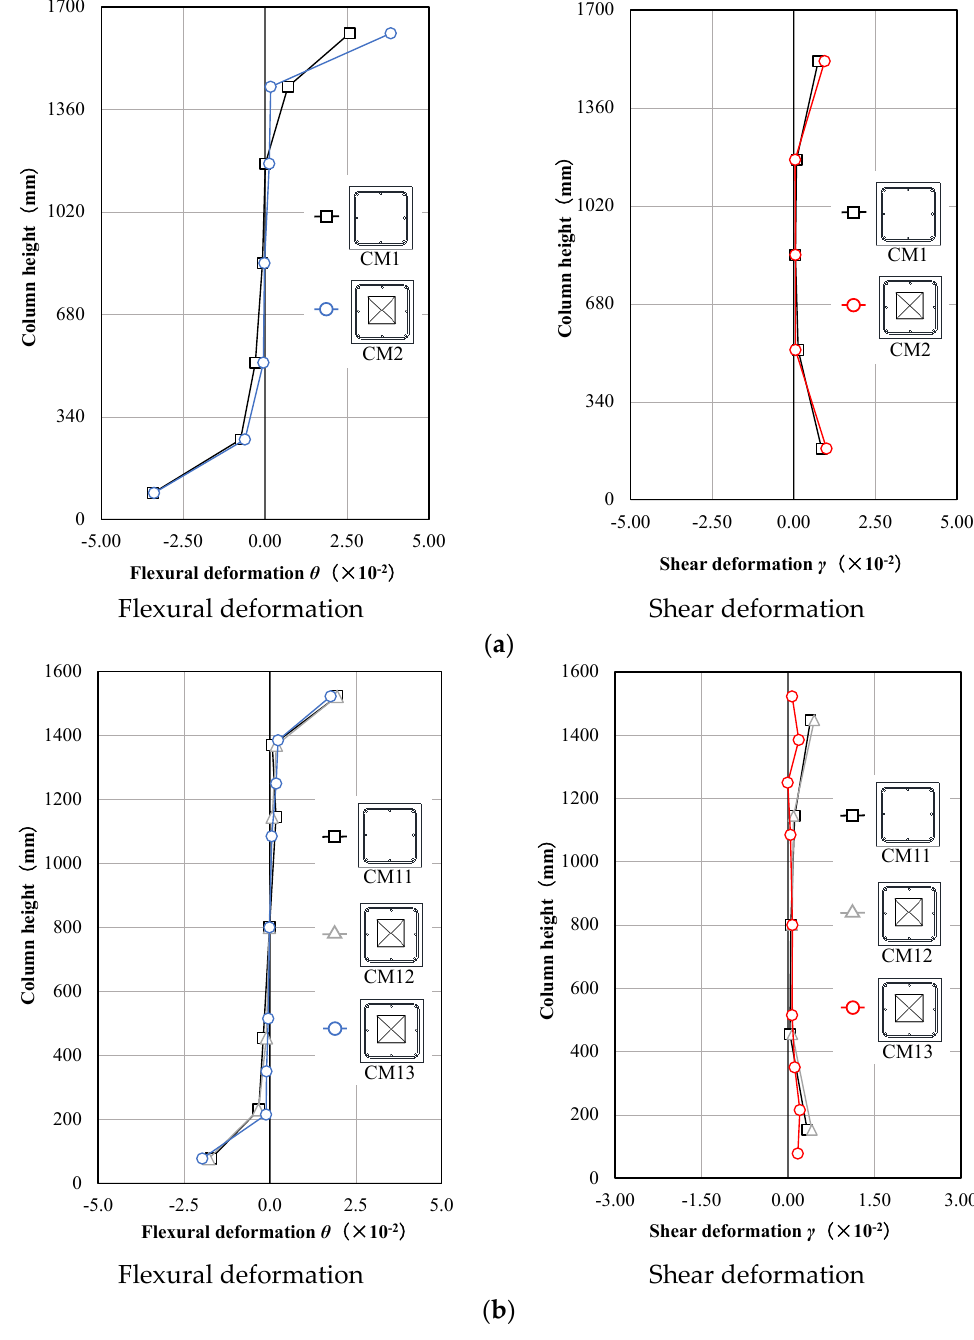
Figure 11. Deformation distribution: ( a ) N-series (R = 4.0%); ( b ) S-series (R = 2.0%). The difference in energy absorption capacity, between solid and hollow sectioned columns, was inspected by comparing their equivalent viscous damping ratios ( h eq